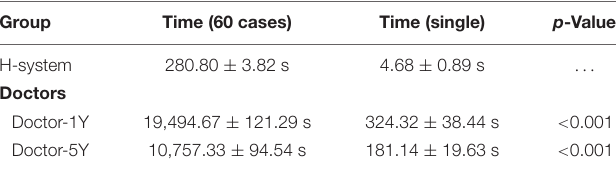
TABLE 5 | Comparison of cases, sensitivity, specificity, and accuracy in a fixed time among H-system and